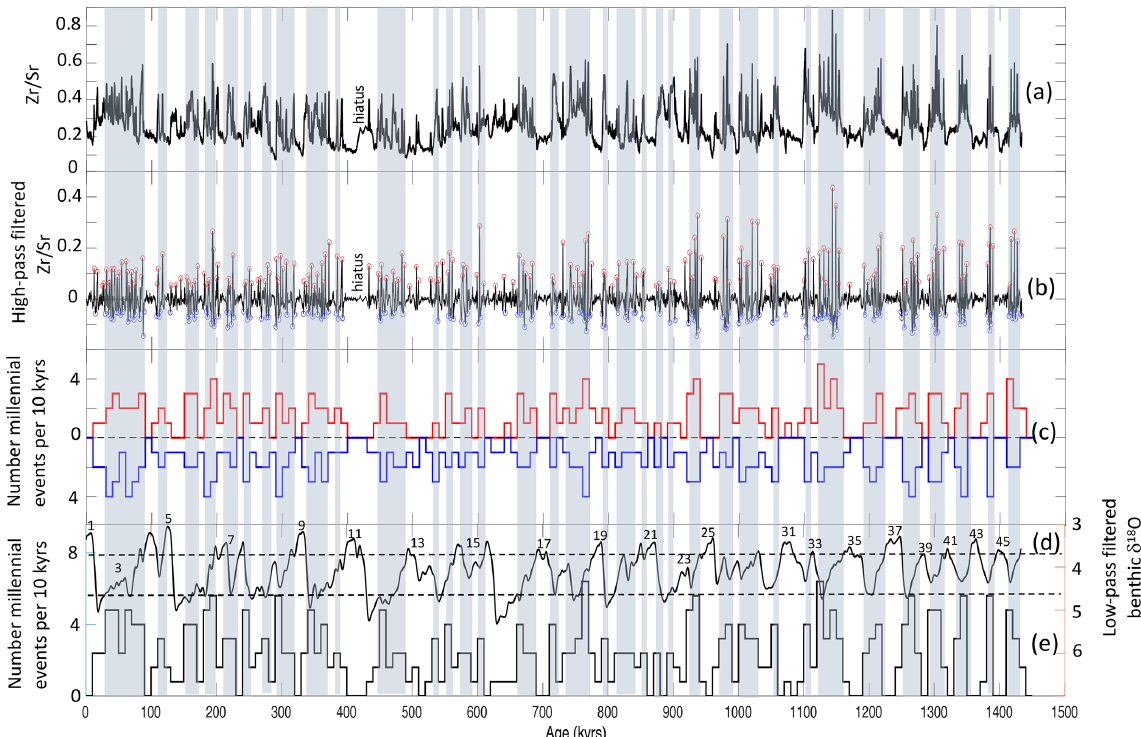
Figure 5. Same as Fig. 4 but for Zr–Sr. The blue shade indicates times when the total number of millennial events equals or exceeds three per 10000 years, which occurs mostly during intermediate glacial